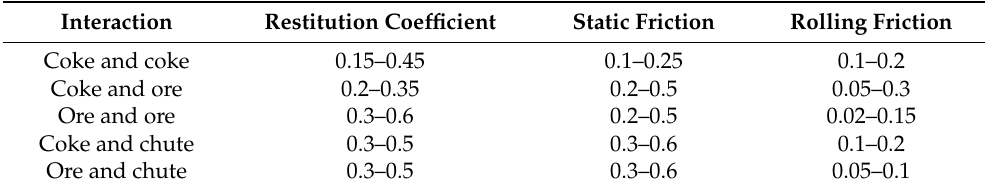
Table 5. The value range of relationship parameters between the contact systems in the charging